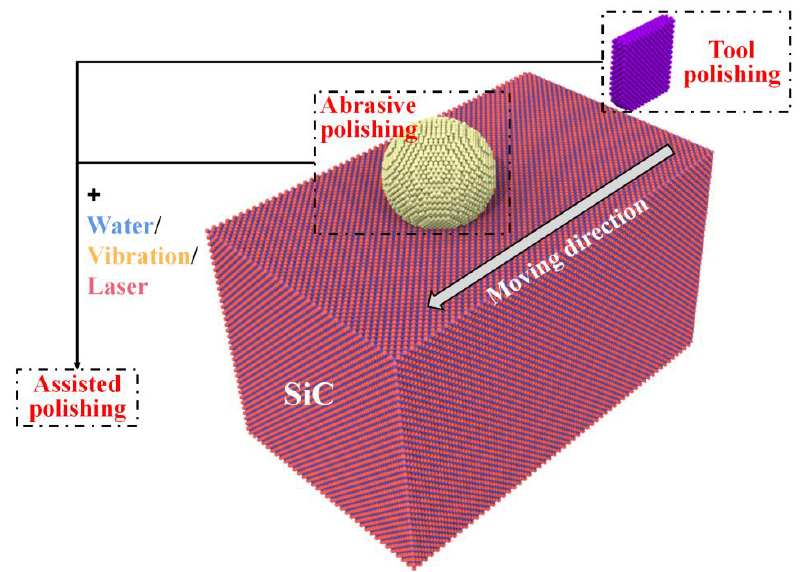
Figure 5. The typical polishing simulation model of SiC